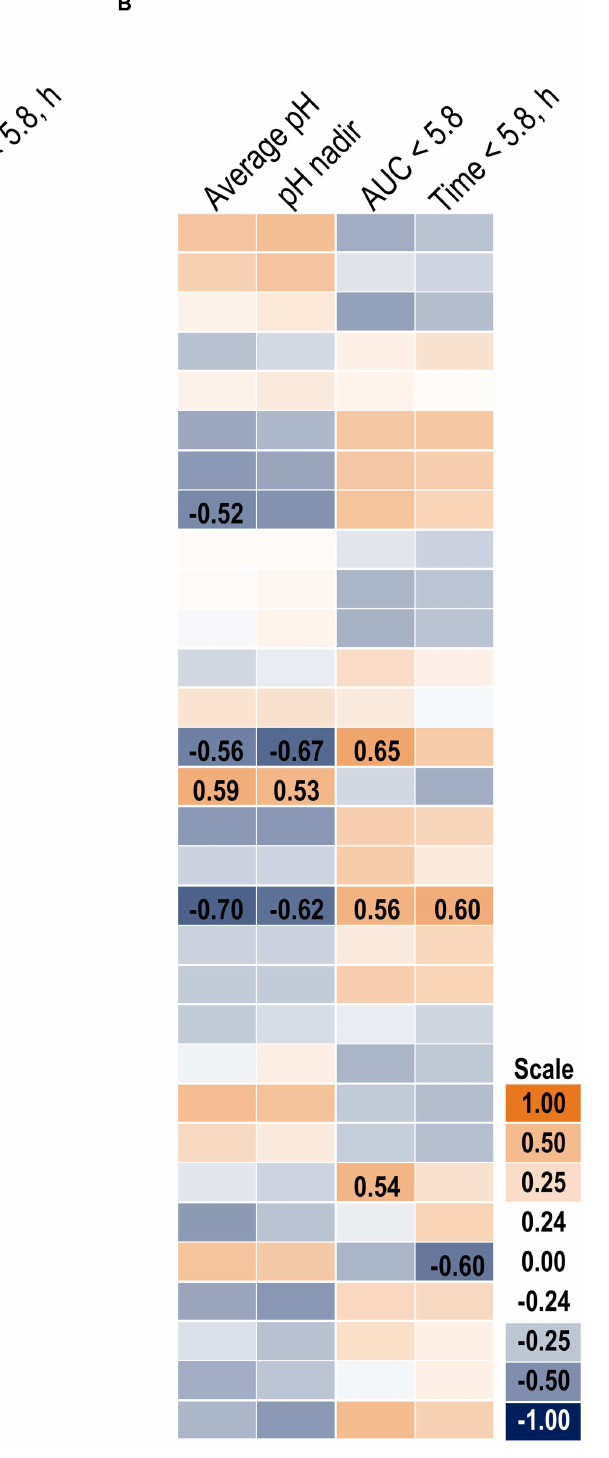
FIGURE 2 | Association heat map between the change in bacterial relative abundance over time (day 6 – day 1) and ruminal pH response on day 5 in the solid (A) and liquid (B) fractions using Pearson correlations. All correlation coefficients greater than 0.5 or less than − 0.5 are listed. The scale bar colors denote the correlation coefficients with 1 indicating a perfect positive correlation (orange) and − 1 indicating a perfect negative correlation. Letter prefix denotes the lowest level of taxonomic identification [genus (g); family (f); and order (o)].